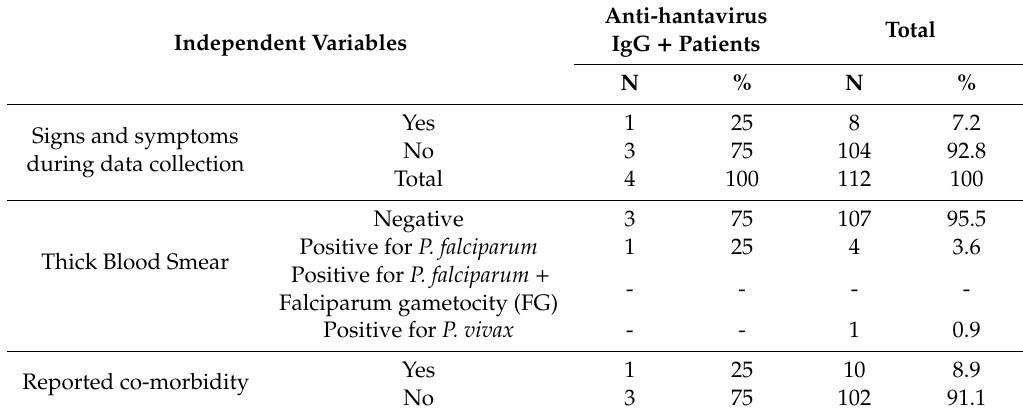
Table 2. The clinical characteristics of 112 residents of Tr ê s Fronterias, state of Mato Grosso, Brazil, 2012. Anti-hantavirus Total Independent Variables IgG + Patients N % N % Yes 1 25 8 7.2 Signs and symptoms No 3 75 104 92.8 during data collection Total 4 100 112 100 Negative 3 75 107 95.5 Positive for P. falciparum 1 25 4 3.6 Thick Blood Smear Positive for P. falciparum + - - - - Falciparum gametocity (FG) Positive for P. vivax - - 1 0.9 Yes 1 25 10 8.9 Reported co-morbidity No 3 75 102